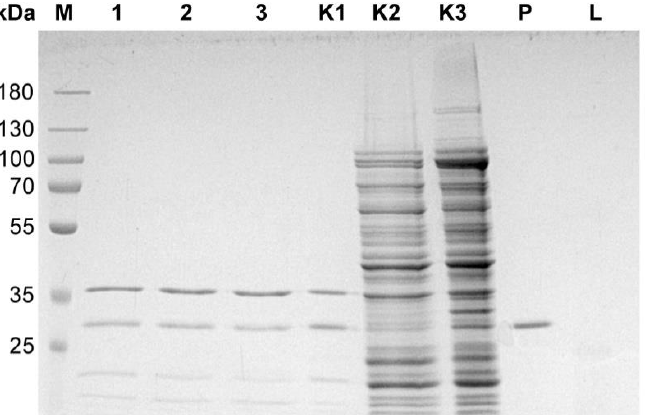
Figure 4. Effect of the presence of various concentrations of CsCl on the activity of proteinase K. Lysate E. coli pPR B5 (0.25 mL culture, OD 600 = 3.6) was digested with 48 µg of proteinase K in various concentrations of CsCl at 55 °C for 30 min. SDS-PAGE/glycine analysis, 12% gel: Lane M, protein marker (PageRuler, Prestained Protein Ladder, 10 to 180 kDa); lanes 1 – 3 samples with CsCl diluted 1:10, 1:7, 1:5; lane K1, sample without CsCl; lane K2, sample without proteinase K, CsCl diluted 1:5; lane K3, sample without CsCl and proteinase K; lane P, proteinase K (80 µg); lane L, lysozyme (50 µg).